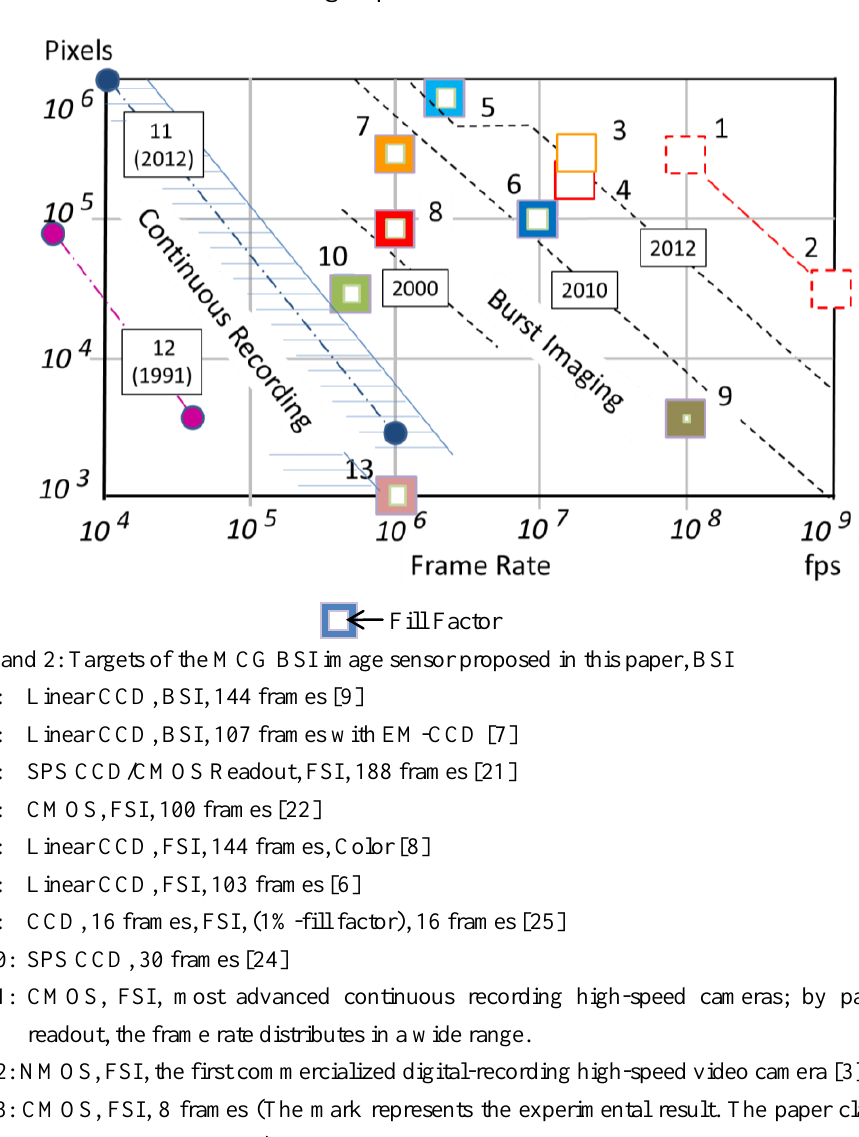
Figure 17. Evolution of ultra-high-speed video cameras: Frame rate vs. Pixel count.